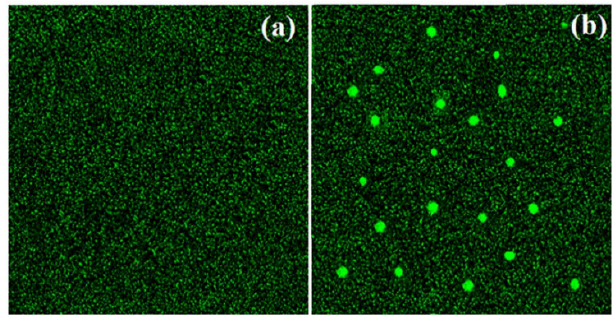
Figure 5. Examination of ROS in the ( a ) absence and ( b ) presence of compound 1 .